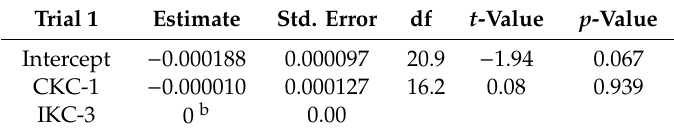
Table 12. The significant di ff erence of the mean of VR obtained in Trial 2 between CKC-1 and IKC-3. Trial 2 Estimate Std. Error df t -Value p -Value Intercept 0.000272 0.000228 16.91 1.19 0.250 CKC-1 − 0.000069 0.000286 18.73 0.24 0.812 IKC-3 0 b 0.00